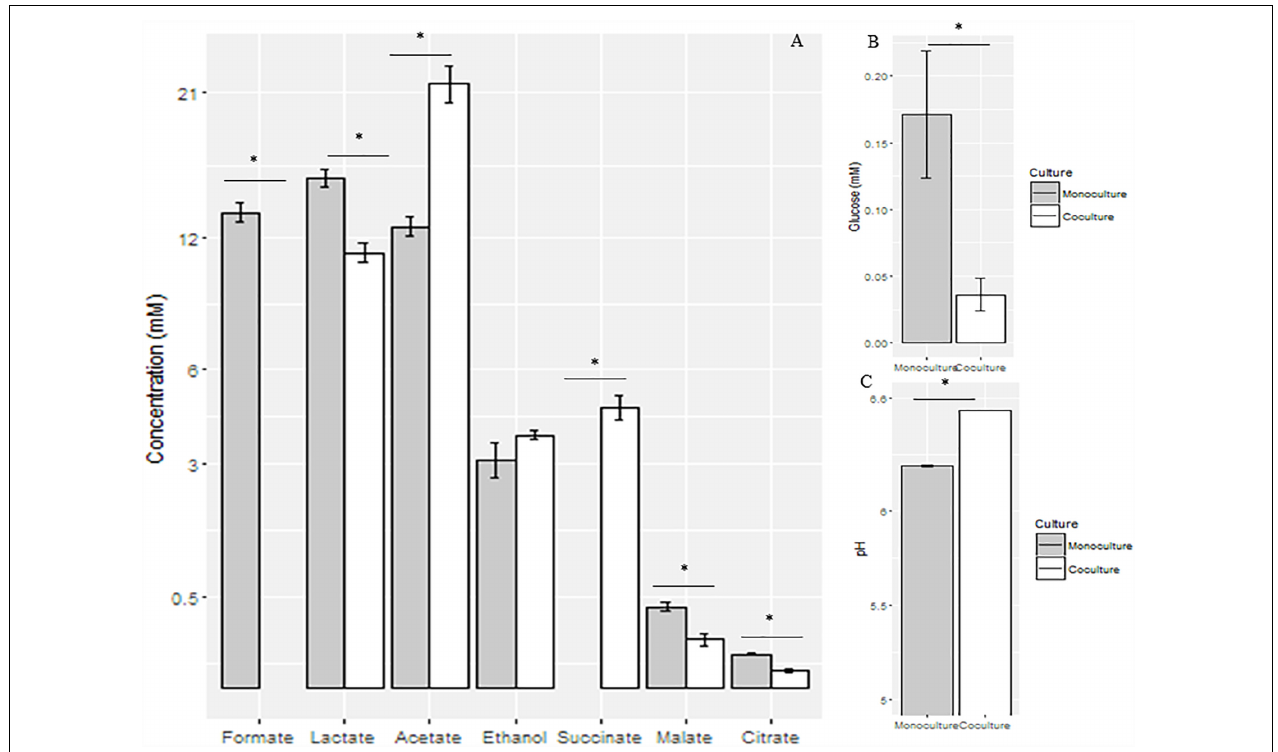
FIGURE 3 | Concentrations of fermentation end products (A) and glucose (B) and pH values (C) in the supernatant of anaerobic fungal monoculture and co-culture at the late-growth stage. ∗ Means significant difference between two